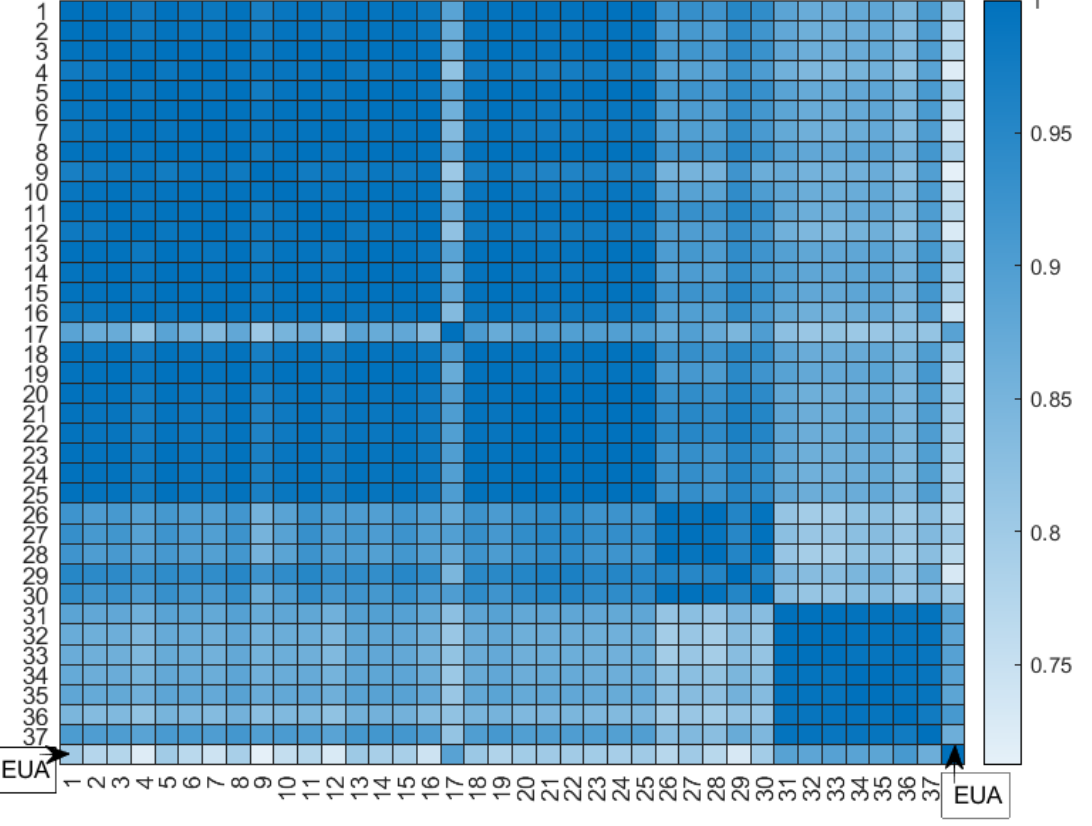
Figure 5. Correlation coefficient matrix (description: indicators numbers identical to Table 1).